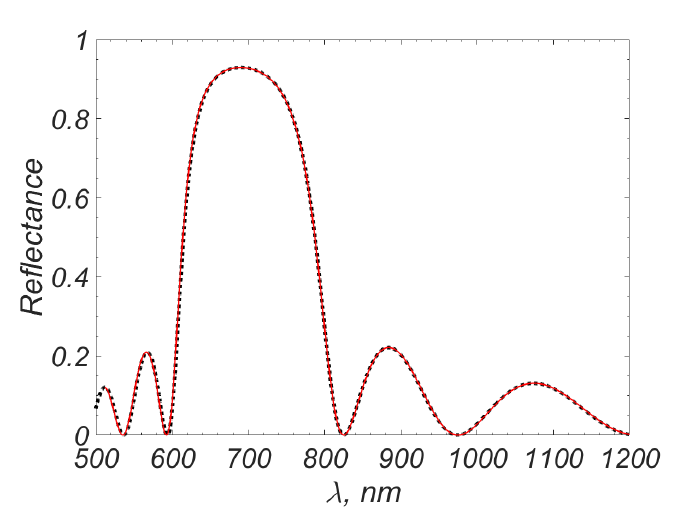
Figure 11. Photonic crystal from Figure 8. Reflection spectrum for the p -polarized wave. The notations correspond to Figure 10.